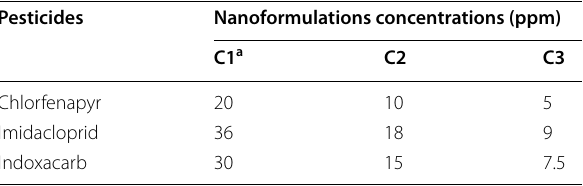
Table 1 The concentrations of nanopesticide formulations used against C. acuta and M. vermiculata adults